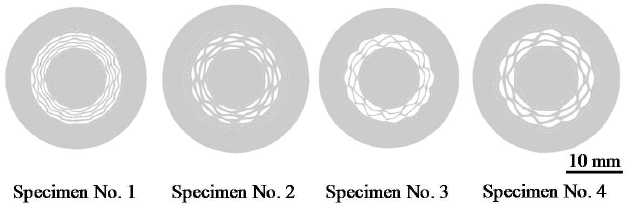
Figure 6. Computationally predicted final deformed shapes of the four analysed specimen configurations (Table 1).